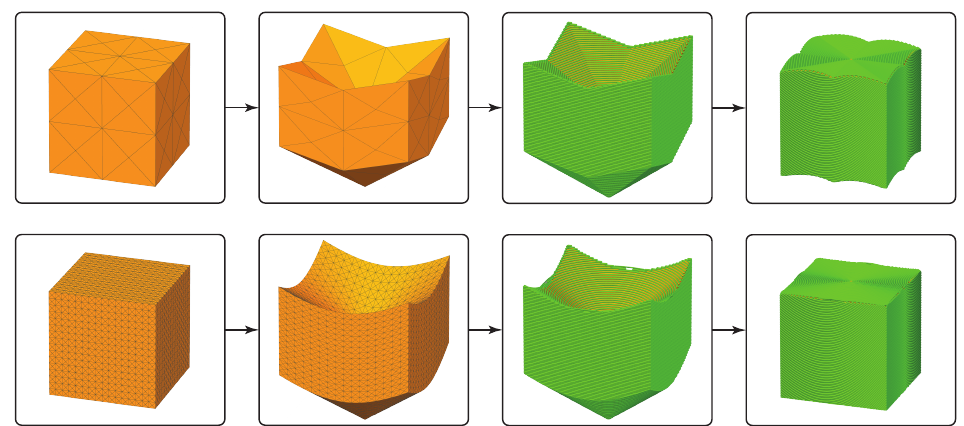
Figure 6. Difference of transformation according to the size of the triangles.